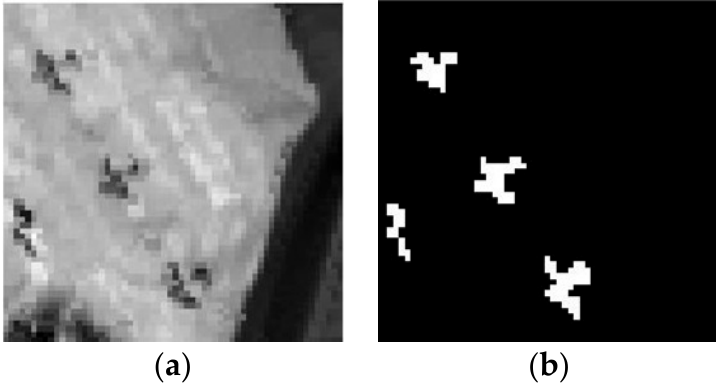
Figure 9. ( a ) The subarea of airport image; ( b ) ground truth of the airport image scene.